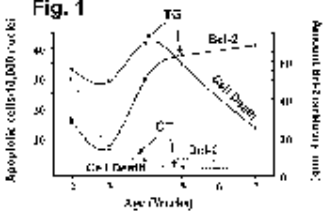
Fig. 1: Mitochondrial DNA mutations cause apoptosis and an anti-apoptotic response. Apoptotic cell death increases in transgenic (TG) versus control (CT) mice when TG mice average one point mutation per mitochondrial genome. The protective protein Bcl-2 is then upregulated, and cell death begins to subside. Still, apoptosis remains high in TG mice to at least 11 weeks-of-age.